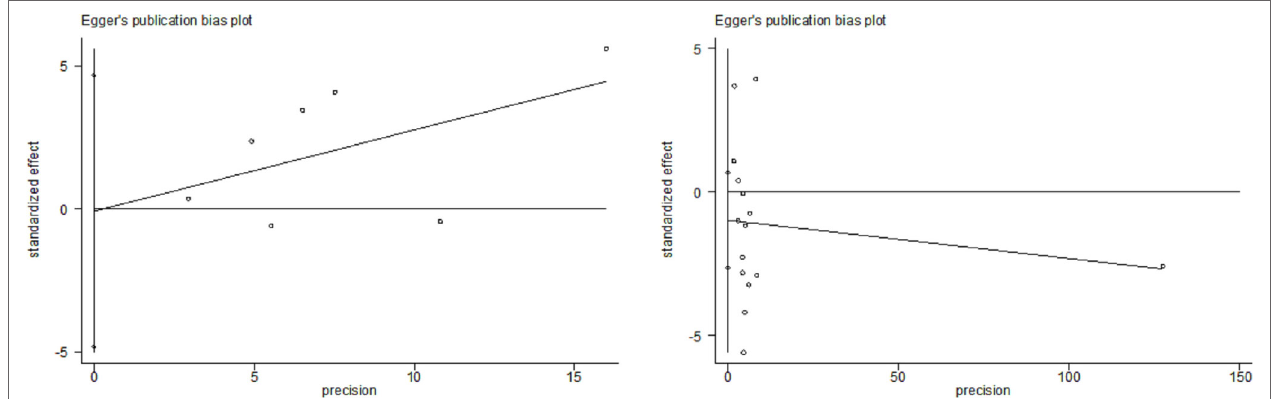
FigURe 4 | Begg’s test and Egger’s test in cohort